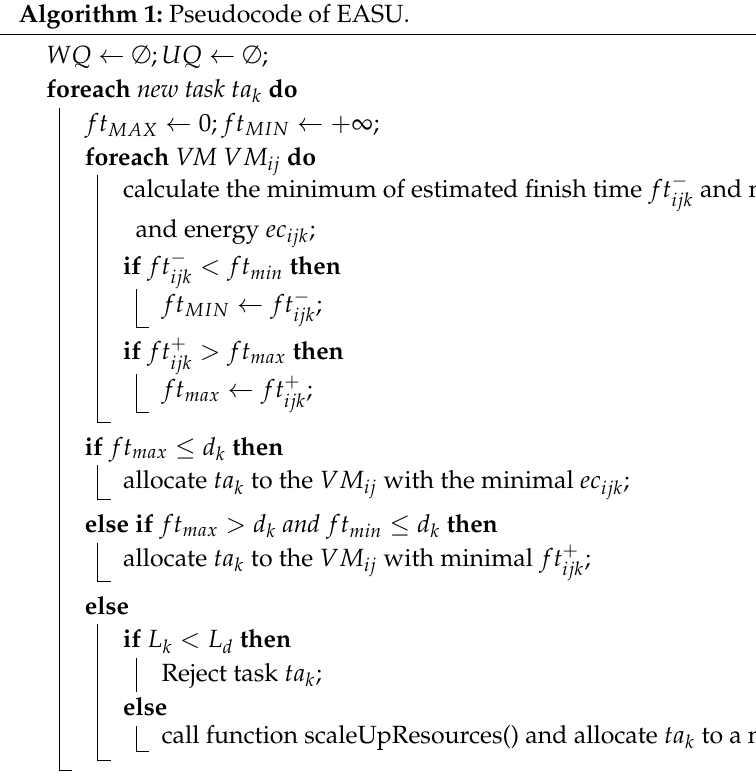
Algorithm 1: Pseudocode of